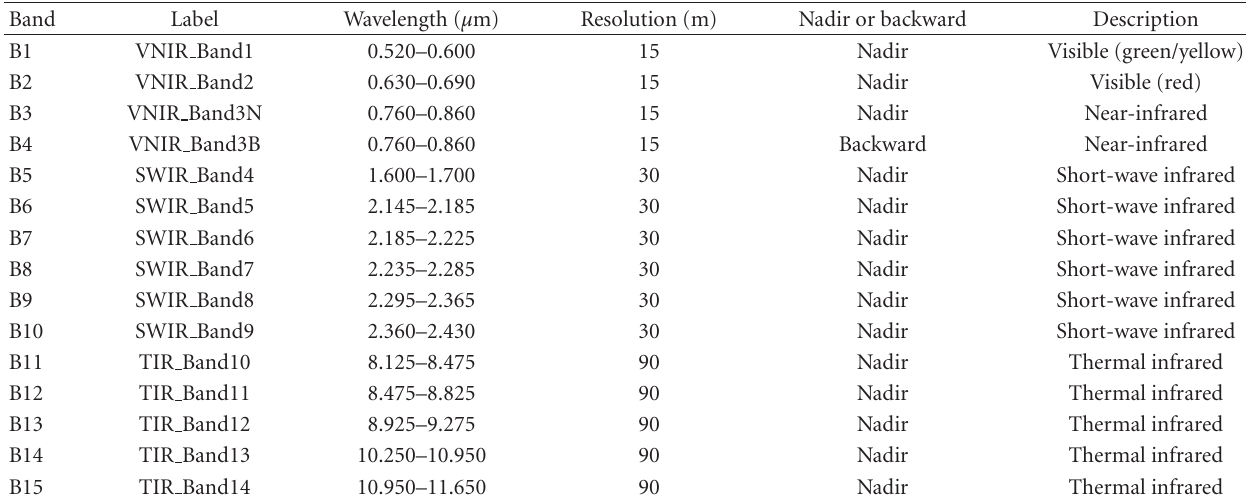
Figure 3: Variation of average soil moisture (%) and cumulative precipitation (cm) conditions during the RADARSAT-1 image acquisition. Table 3: Characteristics of ASTER bands (June 3rd,